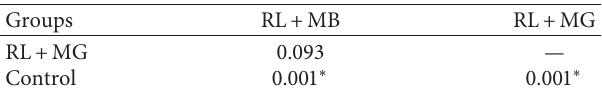
Table 2: Post hoc analysis of the antibacterial effect of the red laser using different photosensitizers.